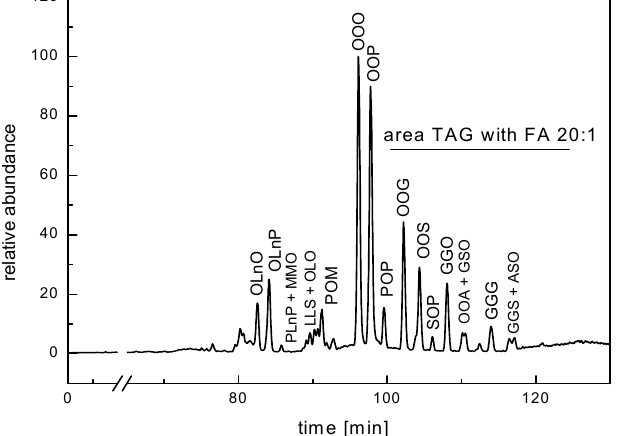
Figure 2. HPLC chromatogram of TG fraction of the fat body extract of B. ruderatus males. FA residues in TGs are abbreviated as follows (in alphabetic order): arachidic (A), gondoic (G), linoleic (L), α -linolenic (Ln), myristic (M), oleic (O), palmitic (P), and stearic (S).